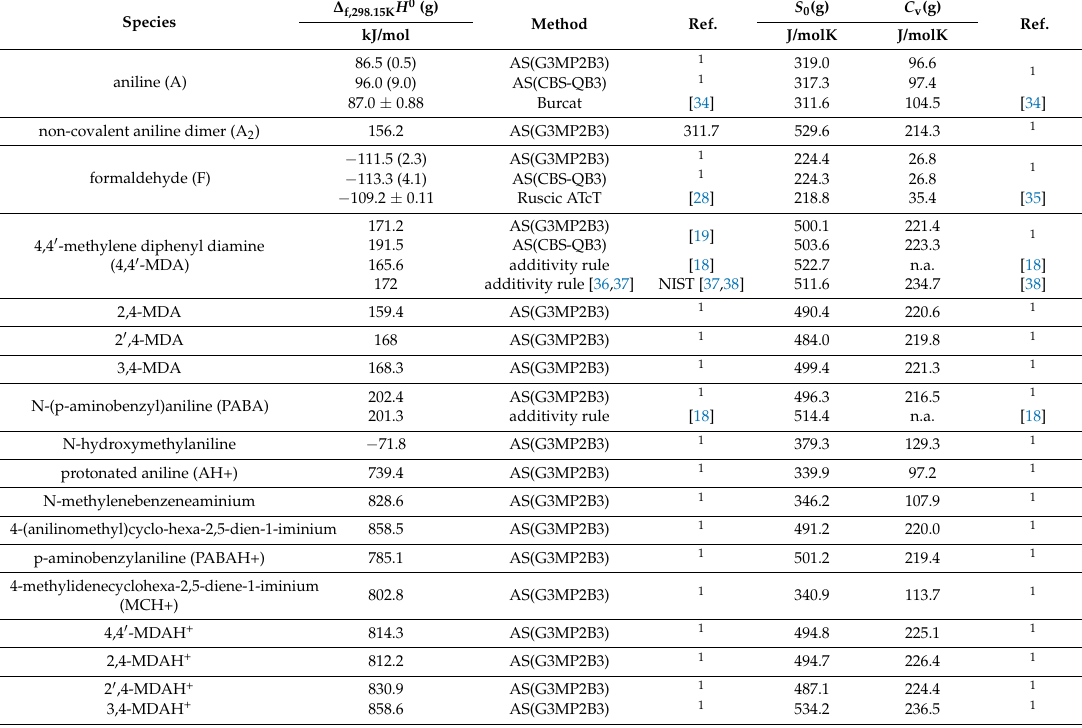
Table 2. Gas phase thermochemical properties for reactants, products and all the intermediates MDA synthesis as well as MDA and MDAH + isomers. Standard enthalpy of formation ( ∆ f,298.15K H ◦ (g)) is calculated from G3MP2B3 and CBS-QB3 enthalpies by means of atomization scheme (AS) at 1 atm pressure at 298.15 K. Absolute deviation is given in